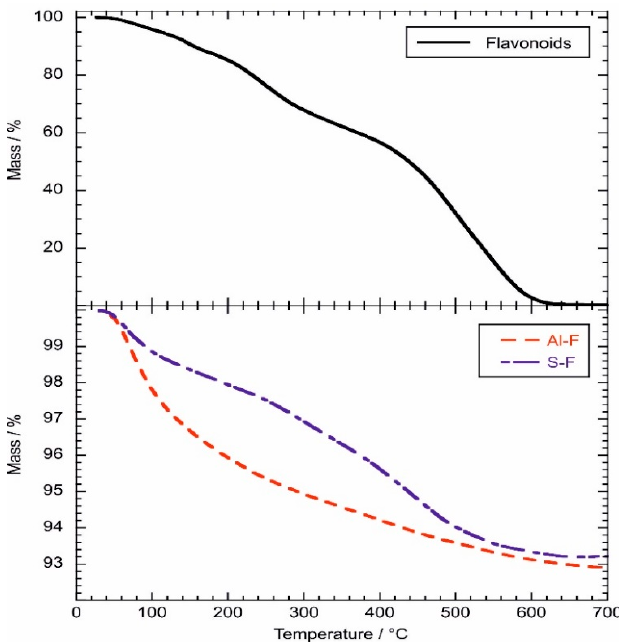
Figure 6. Thermogravimetric curves of pure flavonoids, and Al-F and S-F hybrids.